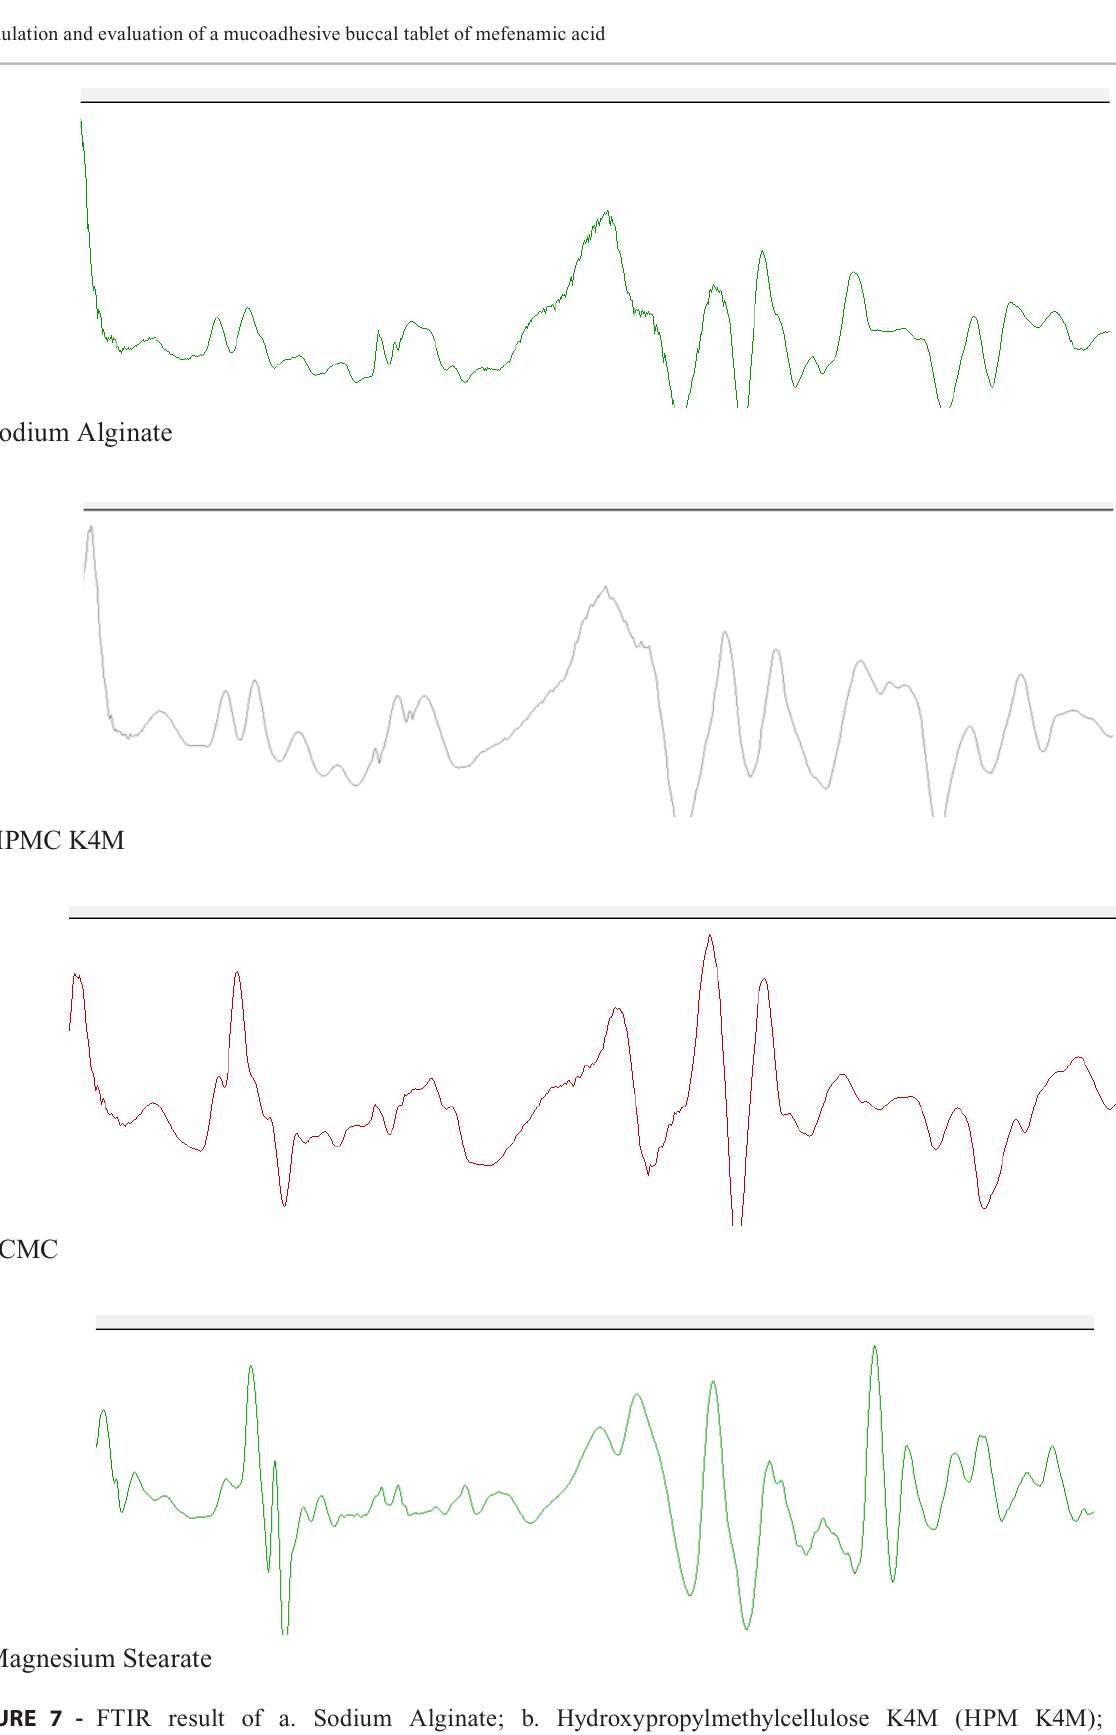
FIGURE 7 - FTIR result of a. Sodium Alginate; b. Hydroxypropylmethylcellulose K4M (HPM K4M); c. Sodium Carboxymethylcellulose (SCMC); and d. Magnesium